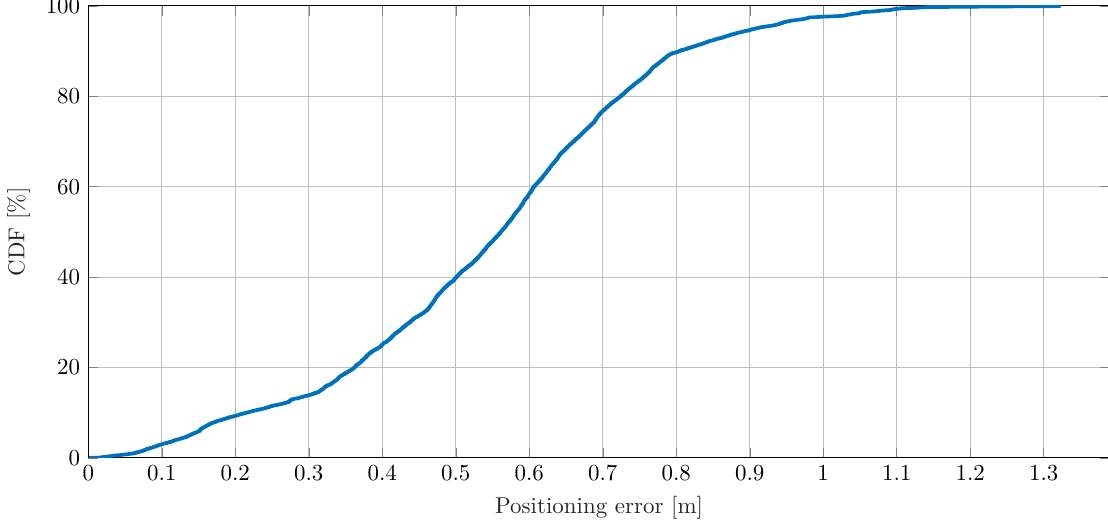
Figure 6. CDF of absolute positioning error for a moving pedestrian